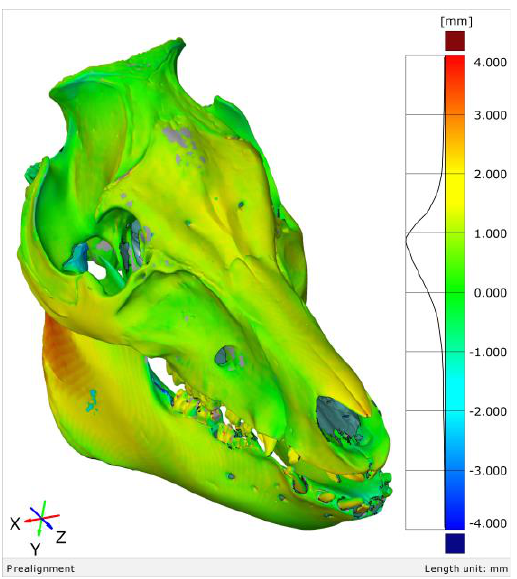
Figure 4. The thresholding error of the segmented SD head on the dry skull with the verified mesh size.